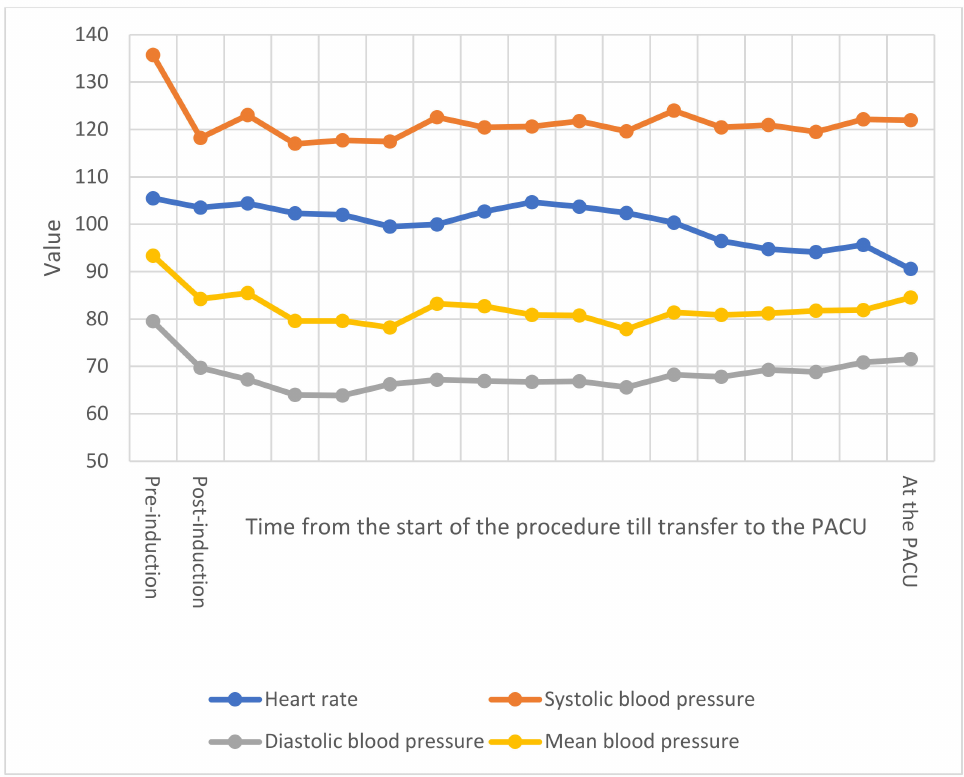
Figure 1. Vital signs in COVID-19 positive patients. The x -axis represents the timing of vital signs obtainment. Intraoperatively, vital signs were documented every 5 min until transfer to the PACU. The y -axis represents the value of vital signs, measured in beats per minute (BPM) for heart rate, mmHg for systolic, diastolic, and mean blood pressure. PACU: post anesthesia care unit. Vital signs are presented along with comparison with COVID-19 negative group in Supplementary Table